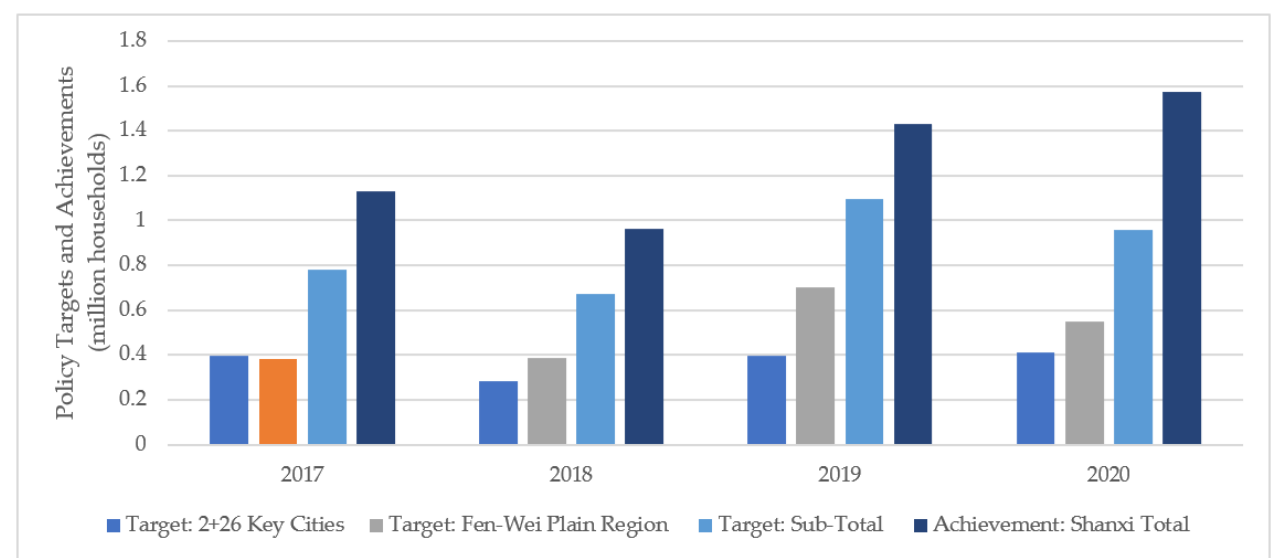
Figure 3. Policy targets and transition achievements in Shanxi. Source: 2 + 26 key cities group [28,69–71]; Fen-Wei Plain region group [62–65,71–73] The Fen-Wei Plain region group’s 2017 target data is from each prefecture-level city’s APCMAP 2017–2018. The unit is one million households.